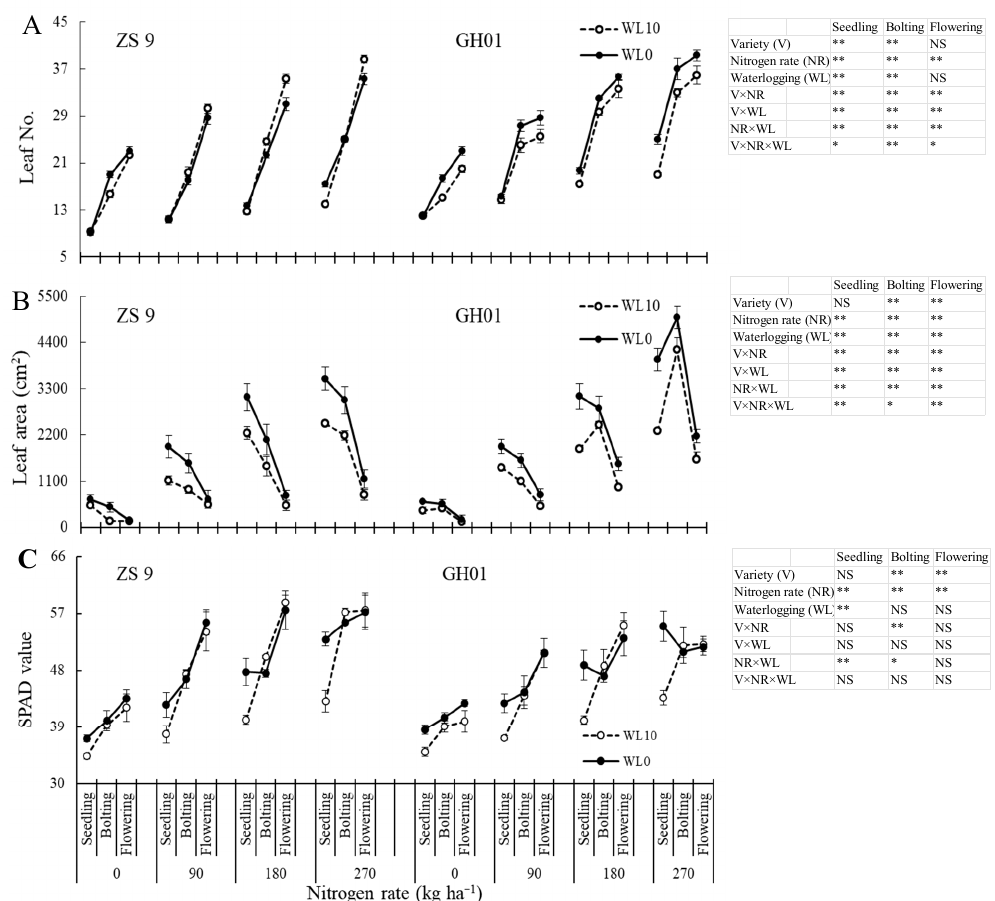
Figure 4. Effects of nitrogen rates on leaf number (A), leaf area (B), and SPAD (C) of waterlogged rapeseed. WL0, plants without waterlogging; WL10, plants waterlogged for 10 days at the seedling stage. * Significant at the 0.05 probability level, ** Significant at the 0.01 probability level. NS, not significant according to ANOVA.